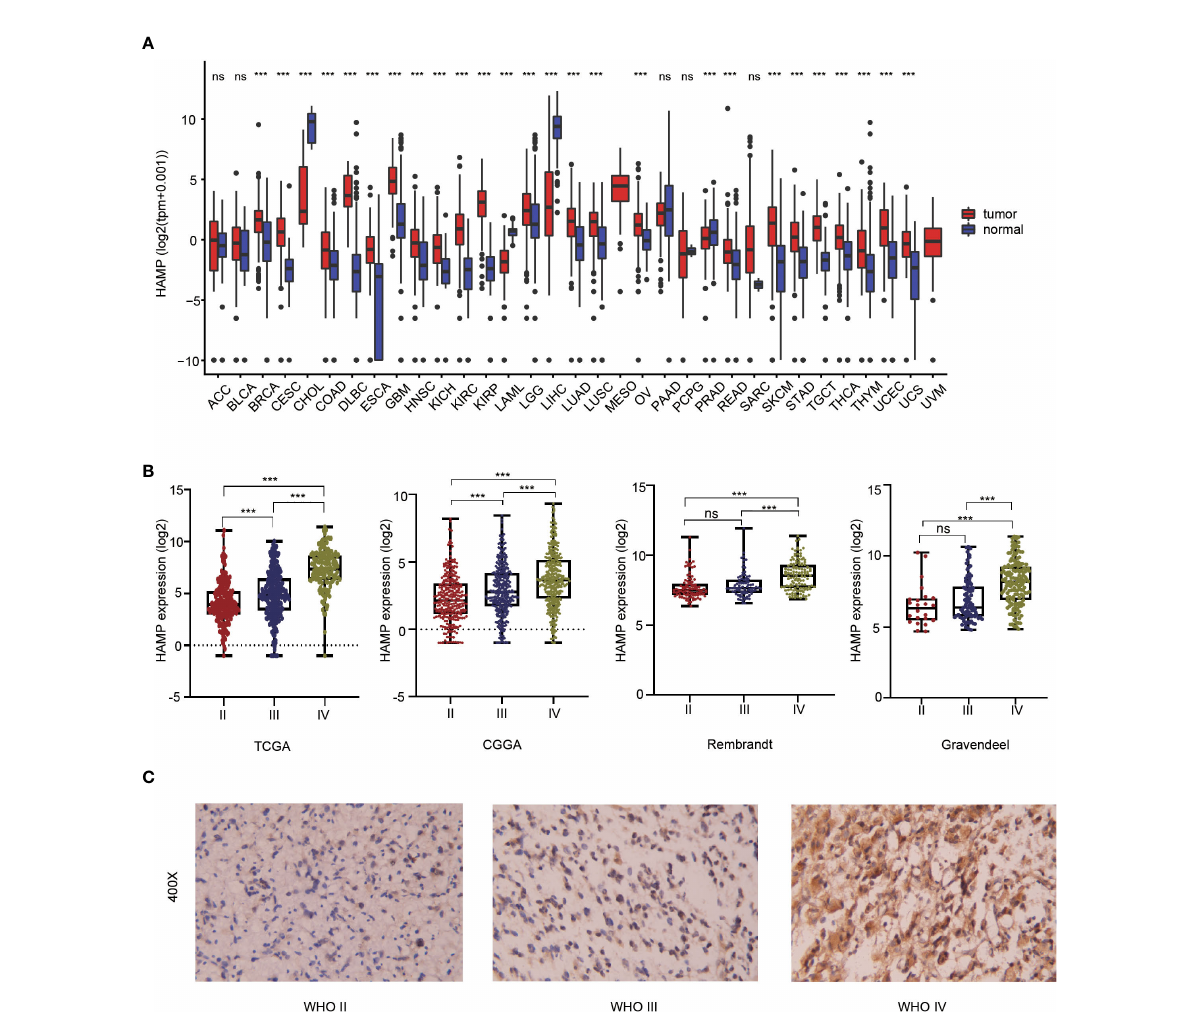
FIGURE 1 Analysis of the relationship between hepcidin expression and glioma grade. (A) Pan-cancer analysis of hepcidin expression in the TCGA database. (B) Relationship between the expression level of hepcidin and grade of glioma. (C) IHC staining of tissues with different glioma grades. ***p < 0.001, ns, not signi fi